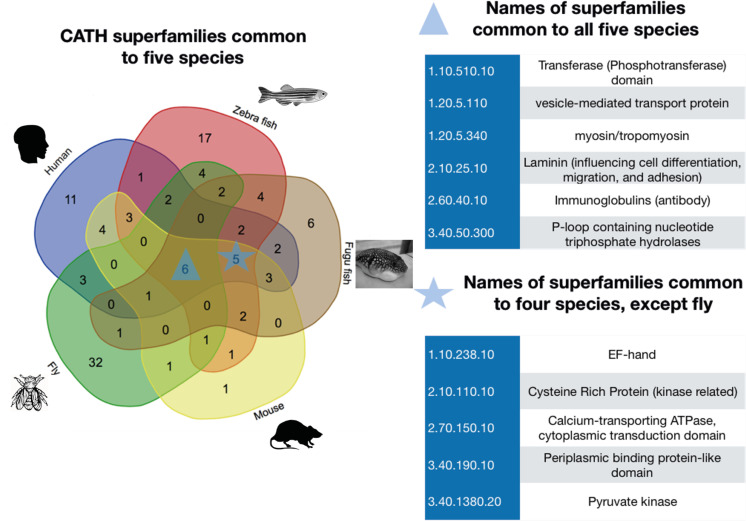
Number and names of CATH superfamilies common to multiple species analysed in this study.MXEs from different species were mapped to CATH domain superfamilies. CATH superfamilies are groups of protein domains with clear evidence of homology. The CATH superfamily code is denoted by four numbers corresponding to each level in the CATH classification (i.e. 3.20.20.120). At the top of the hierarchy is the class level where structural domains are classified based on their secondary structure content. The second level of the hierarchy is the architecture level given by the global arrangement of secondary structures in 3D space. This is followed by the topology level where domains with similar folds (which takes into account the 3D arrangement, orientations and connections between the secondary structures) are grouped together. The fourth level is the homologous superfamily level where domains are deemed homologous. A website tool (http://bioinformatics.psb.ugent.be/webtools/Venn/) was used to draw this Venn diagram.